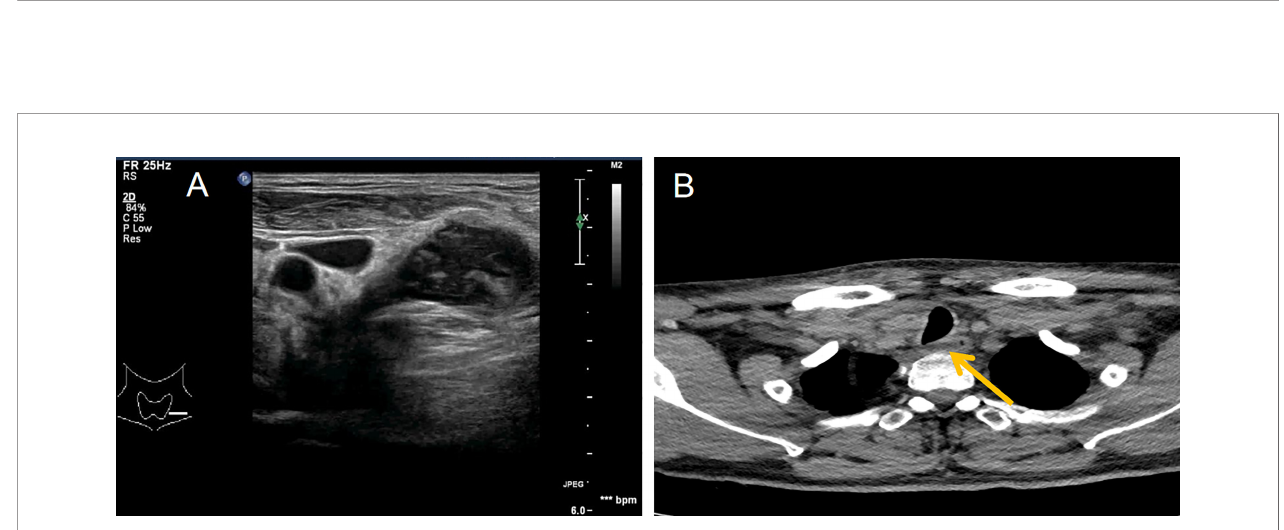
FIGURE 3 | Ultrasound and computed tomography showing the posterior neck. (A) Ultrasound showing mixed echoes on the left side of the neck, poorly demarcated from the surrounding soft tissue and appearing to extend deep into the neck. This presentation is similar to the formation of tuberculous sinus passages in lymph nodes. (B) Neck computed tomography showing streaky fl uid density shadows in front of the cone (yellow arrow